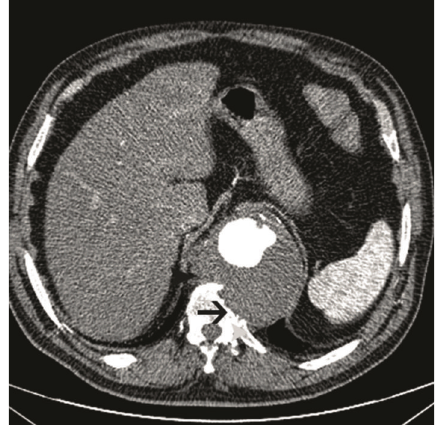
Figure 2: Contrast-enhanced axial multidetector CT angiography image obtained at the level of thoracal 11th vertebra reveals chronic- contained aneurysm rupture of the aorta with vertebral erosion and lysis. Draped aorta sign is present (arrow). Aortic lumen was irregular at the left side.